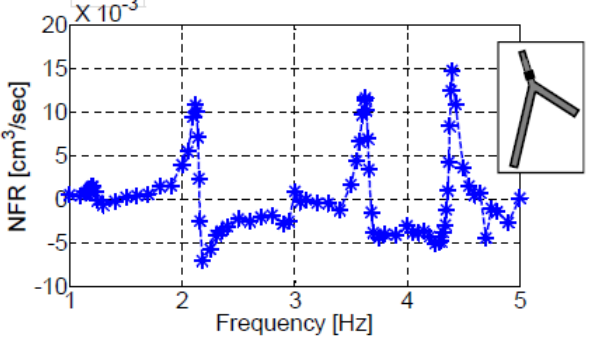
Figure 6. The dependence of NFR on the actuation frequency for configuration III-b. The actuator was located on the first vessel at X C / L = 0.75.